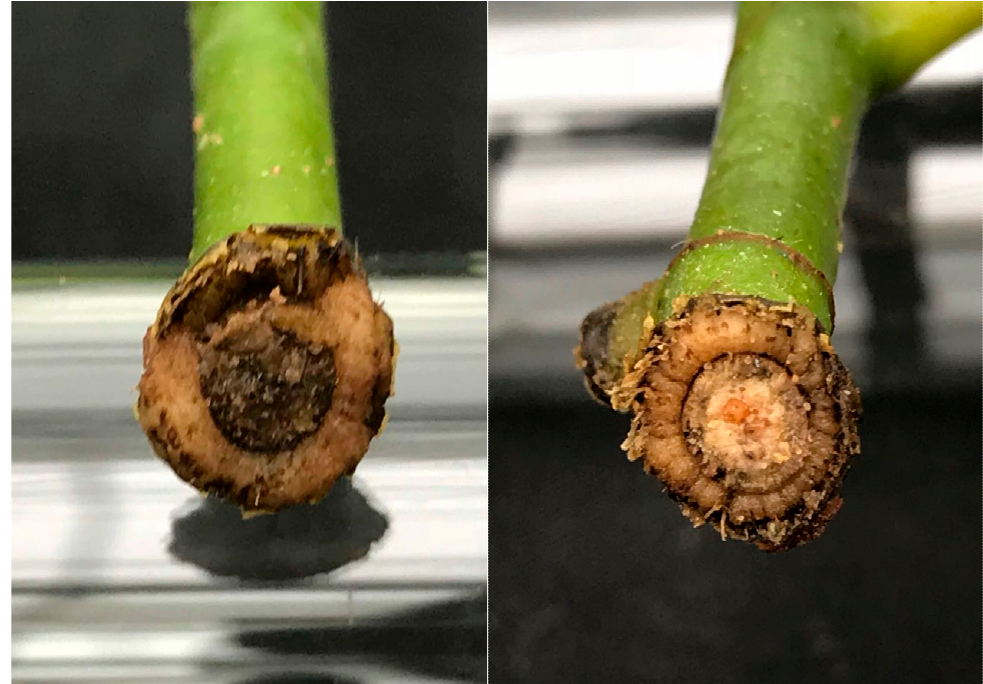
Figure A1. At 13 days after planting, cuttings in Control formed some white callus tissues on the epidermis.